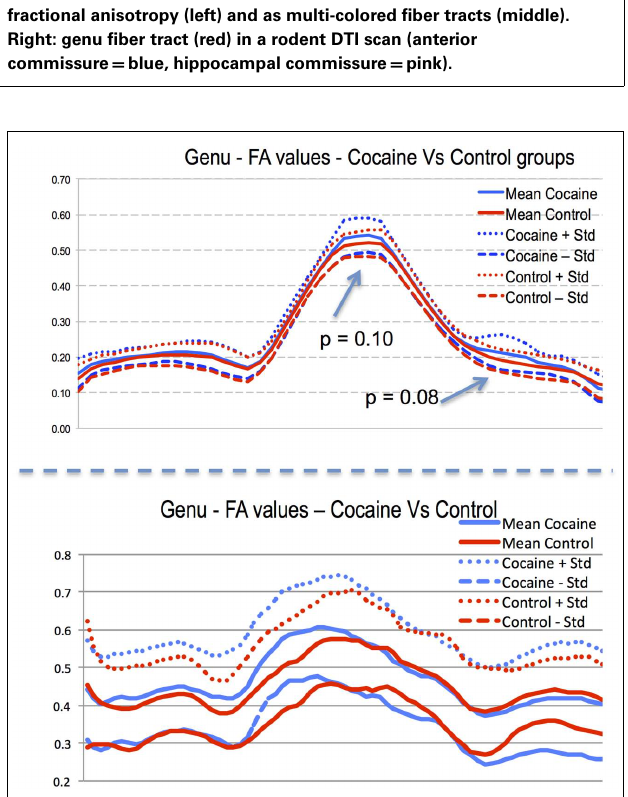
FIGURE 7 | Preliminary DTI–FA profile results of the genu fiber tract in the intra-uterine cocaine-exposure study (plot shows left hemisphere to right hemisphere). Top: human subjects, bottom: rodent subjects. Few locations show statistical trends with surprising similarities across-species in group differences along most of the